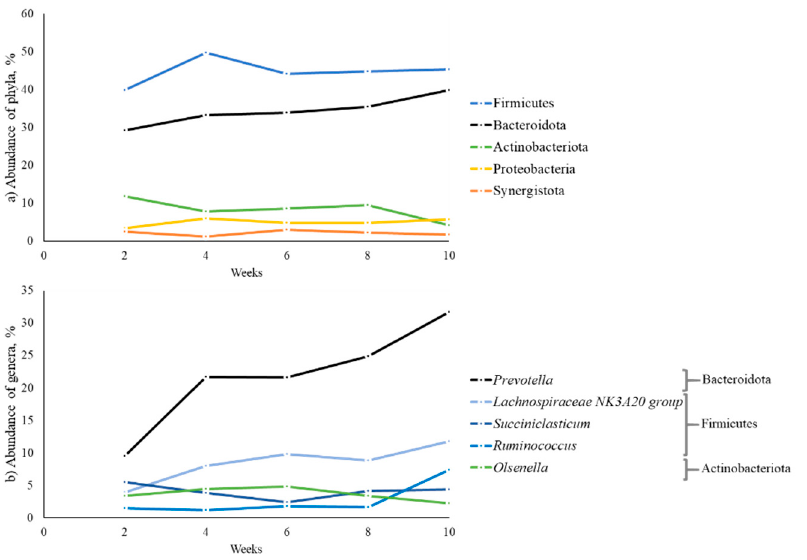
Figure 2. Relative abundance of bacterial phyla and genera in ruminal fluid samples during pre- and post-weaning in dairy calves fed different levels and sources of NDF.